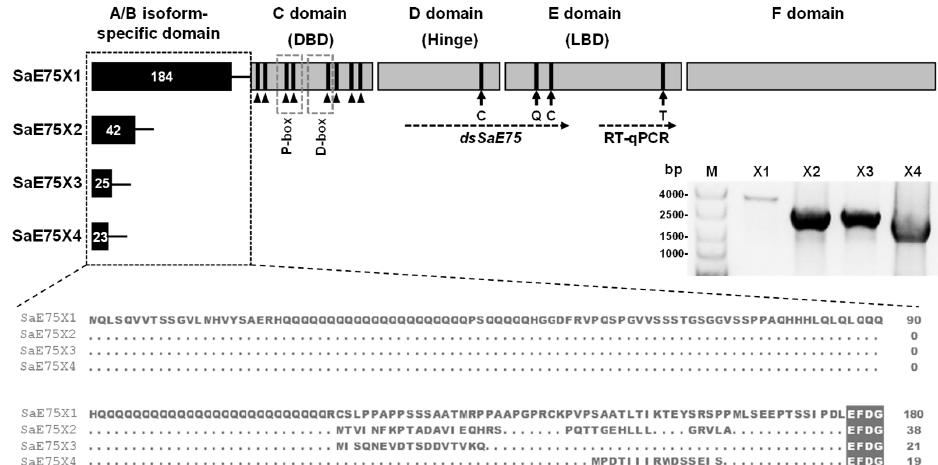
Figure 1. Structural analysis of four isoforms of S. avenae SaE75 . The number of amino acids of each domain is indicated. The specific A/B domain with a different N-terminal sequence is illustrated in a black dotted box, and the different sequence alignments are shown. The C domain (DNA-binding domain, DBD), D domain (Hinge), E domain (ligand-binding domain, LBD), and F domain are highlighted in gray rectangles, which all have the same amino acid sequences among the four isoforms. The cysteine residues of the two zinc finger motifs are labeled by black triangles, and the P-box and D-box in the DNA-binding domain are illustrated in gray dotted boxes. The key amino acid residues involved in heme binding are labeled by arrows. The long-dotted arrow indicates the primer amplification region for RT-qPCR and ds SaE75 . Electrophoretic analysis of full-length sequences of the four SaE75 isoforms is shown in the right middle region. M: DL 15,000 Plus marker (Beijing Zoman Biotechnology Co., Ltd., Beijing,